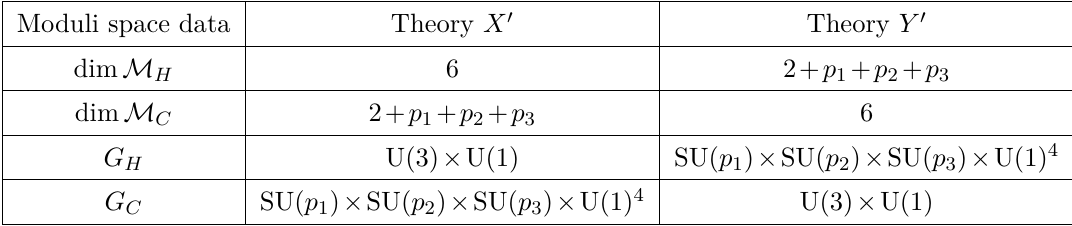
Table 7 . Summary table for the moduli space dimensions and global symmetries for the mirror pair in figure